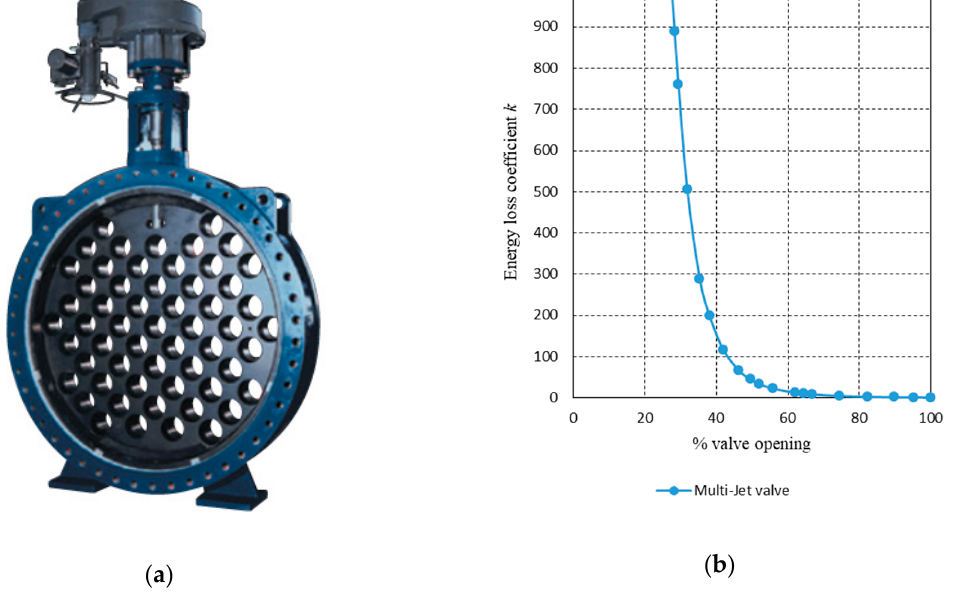
Figure 9. ( a ) Multi-jet regulation valve; ( b ) Graphic of energy loss k [44].